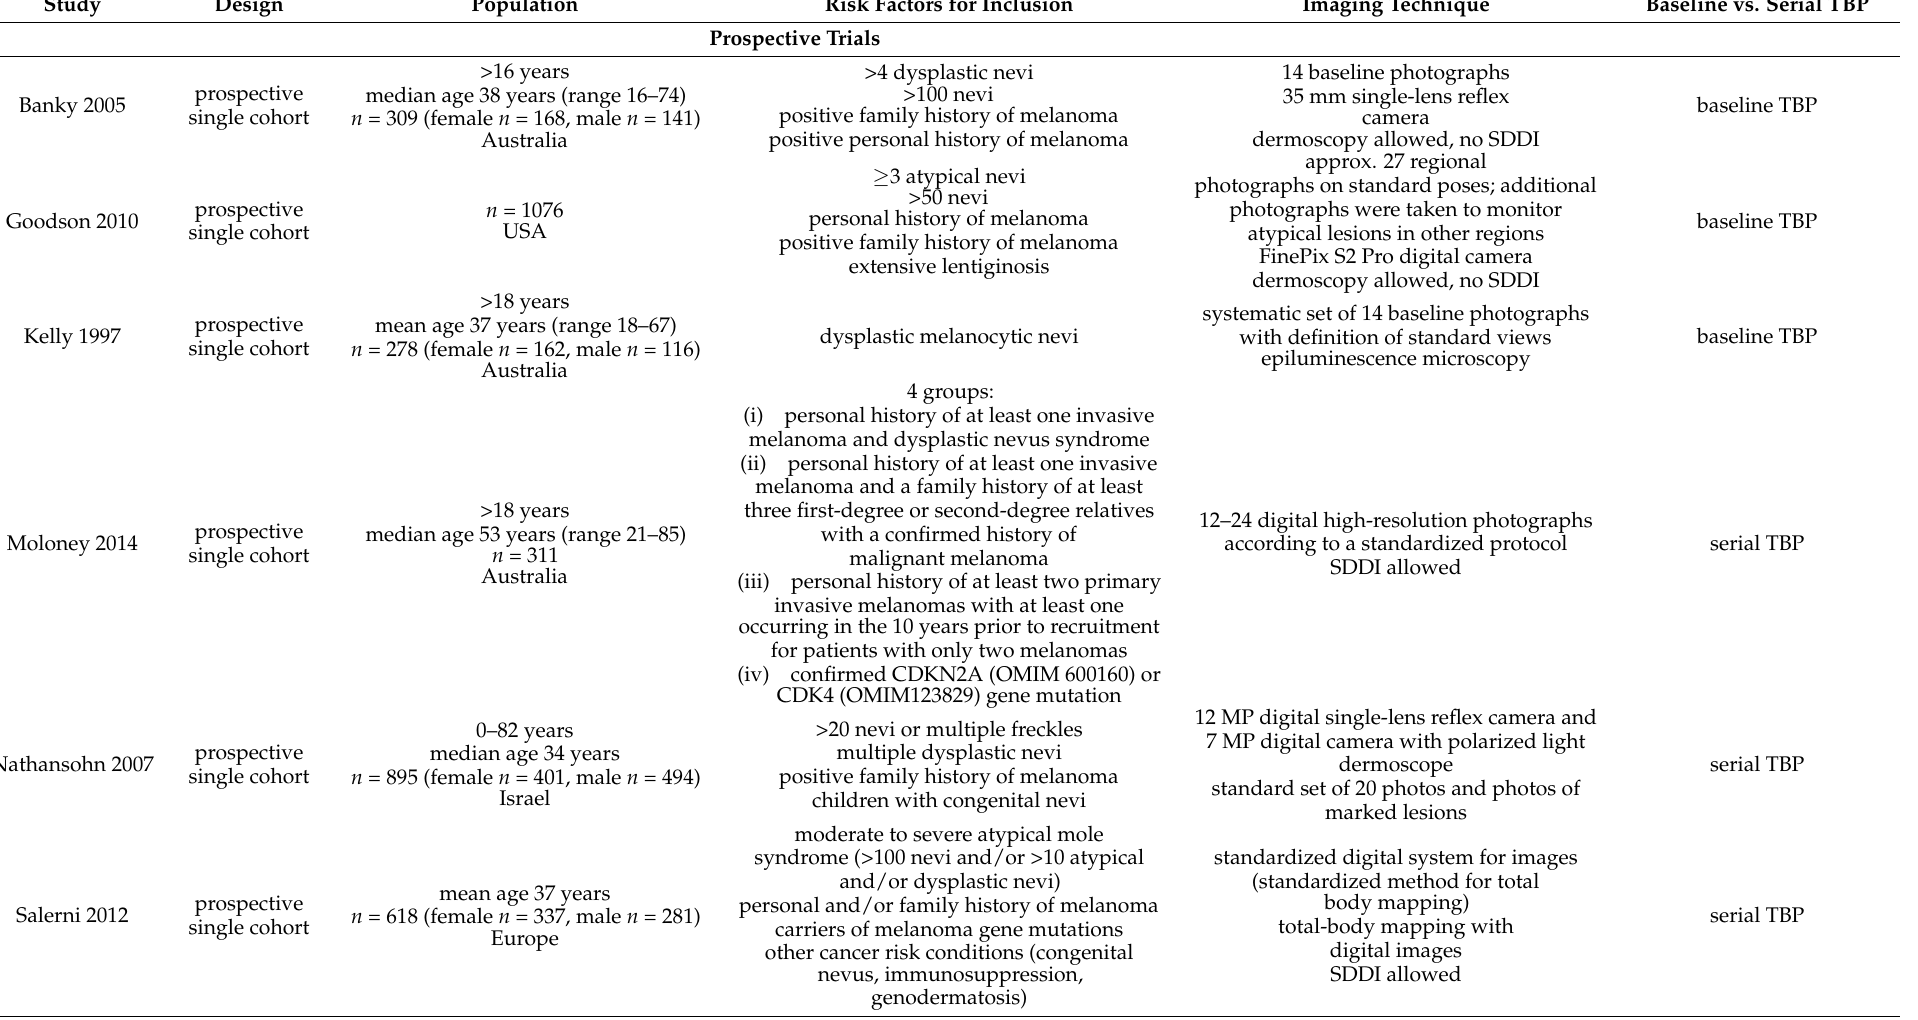
Table 2. Baseline Characteristics of the Included